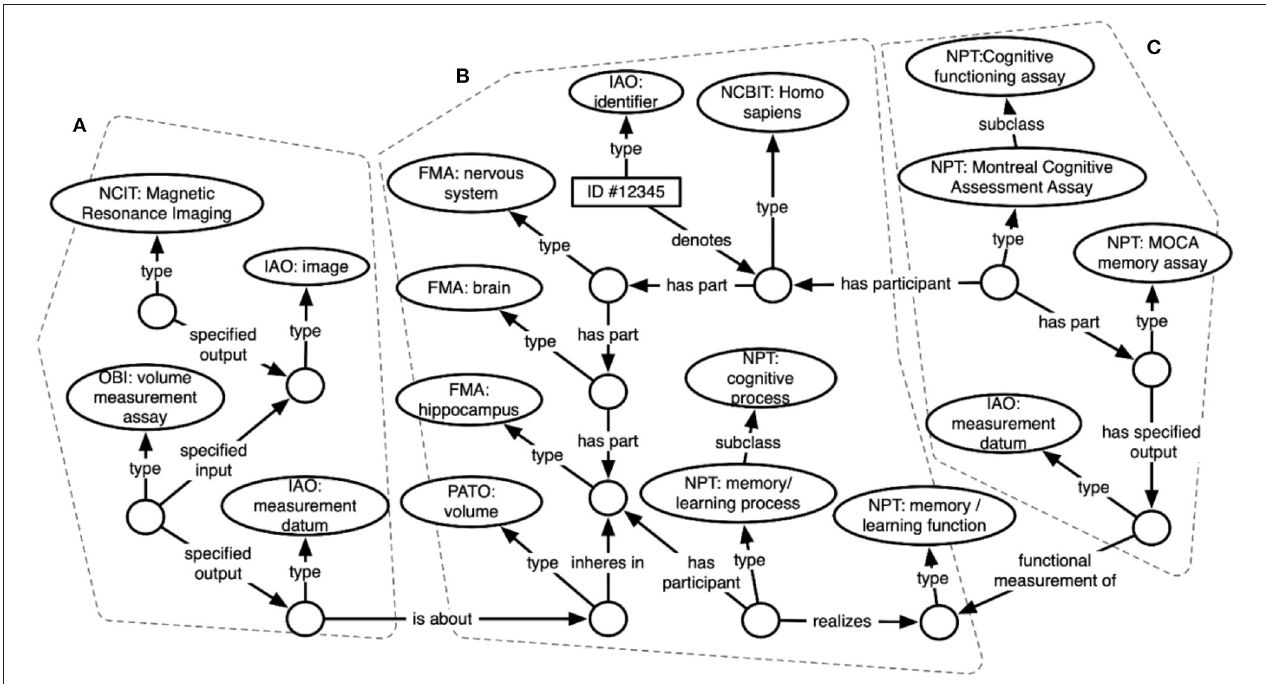
FIGURE 3 | ARIES knowledge graph data structure showing ontology-based representations of (A) an image capture and image-derived volume measure, (B) a human subject, and (C) a cognitive